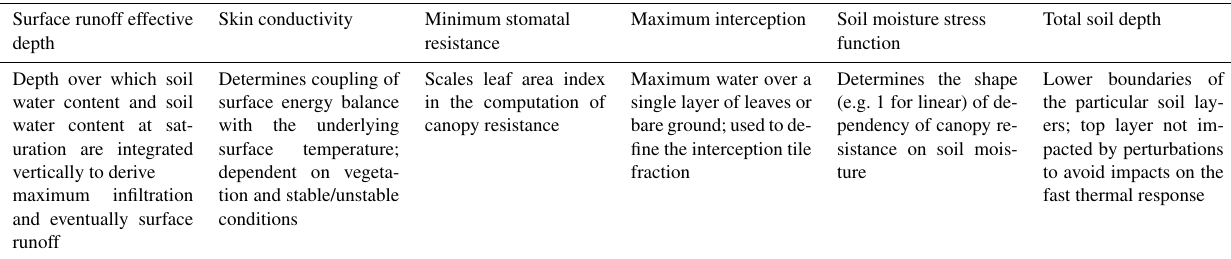
Table 2. Summary of perturbed model parameters and their characteristics (adapted from